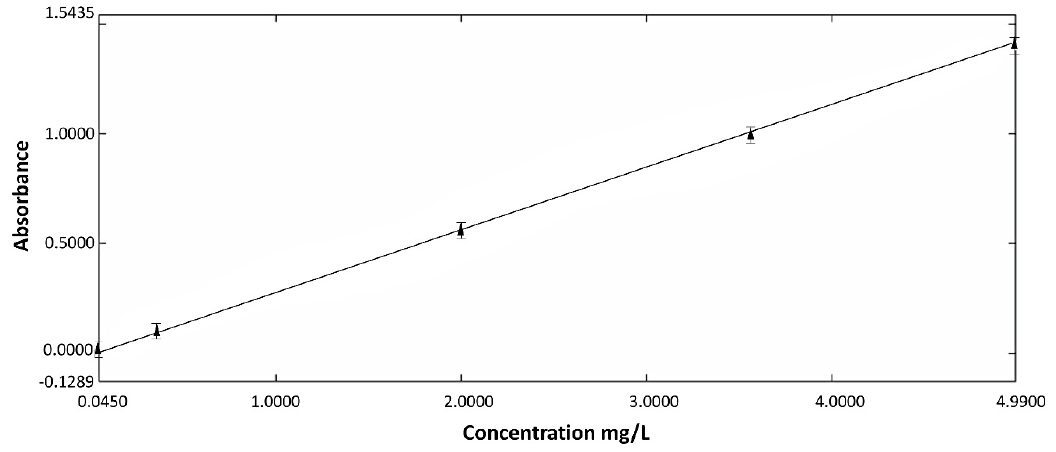
Figure 3. Calibration curve (520.0 nm) based on the concentration of Fe 2+ (r 2 = 0.9973).